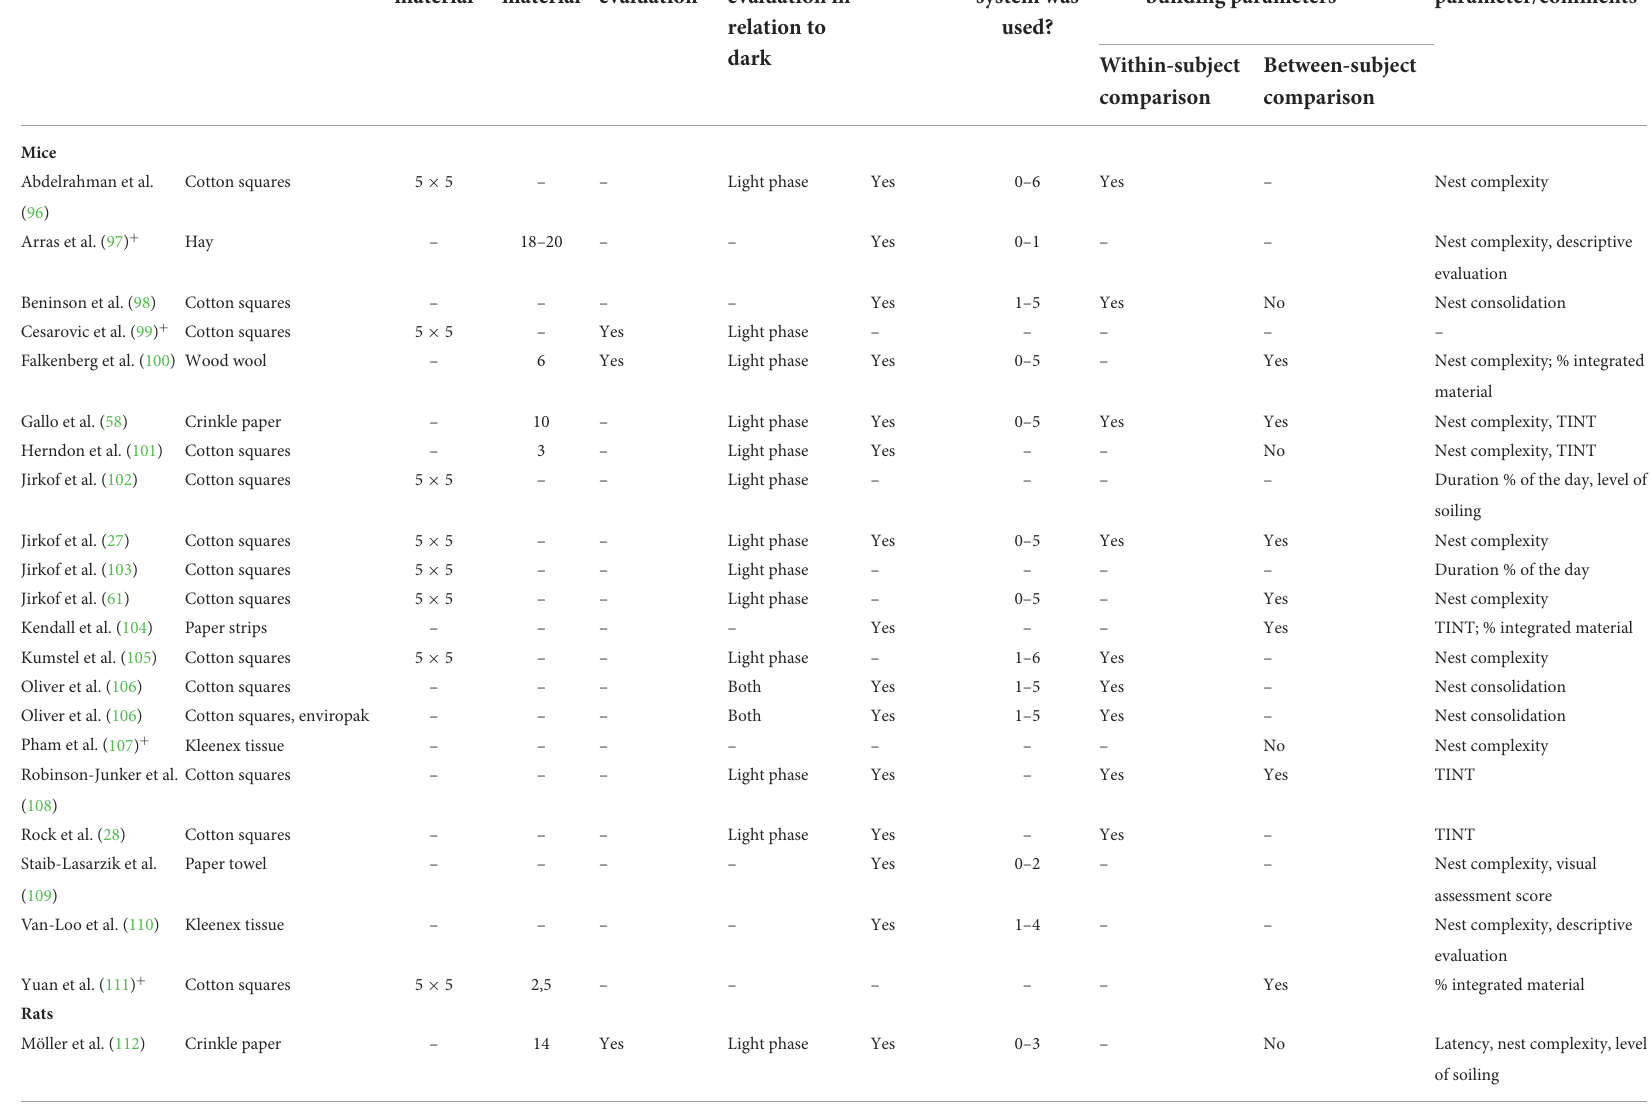
TABLE 7 Outcome characteristics for nest building in mice (k = 20 studies) and rats (k = 1